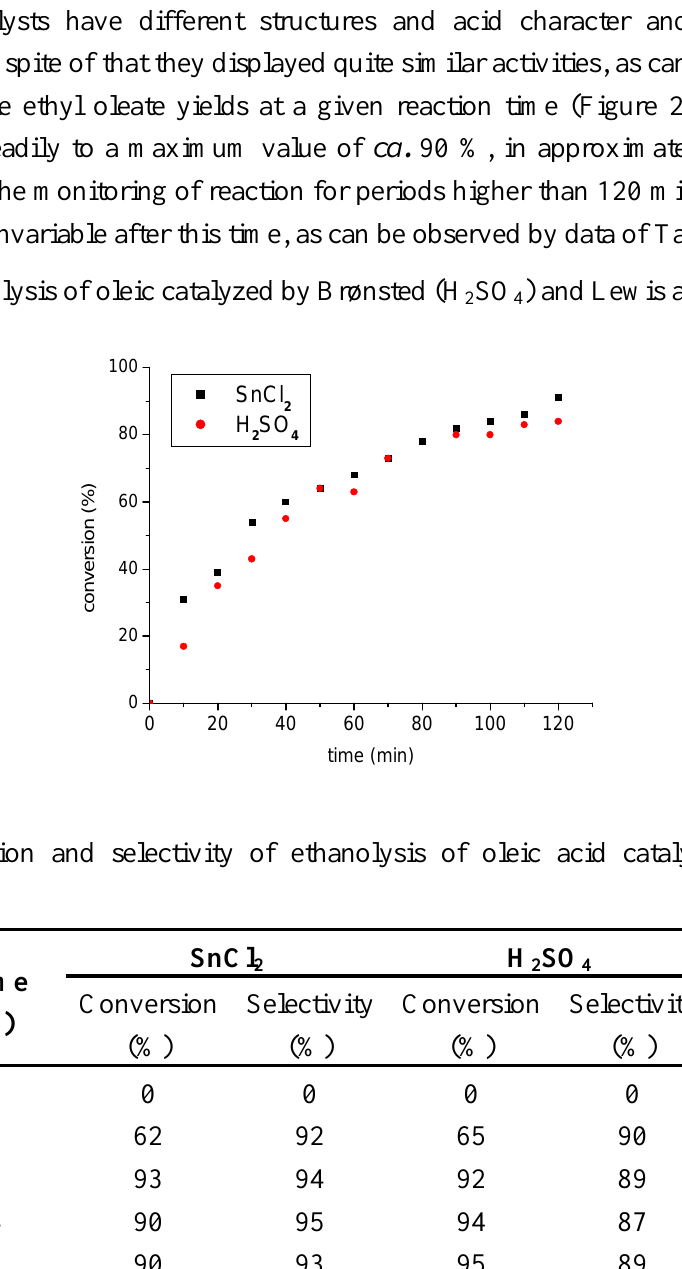
Figure 2 . Ethanolysis of oleic catalyzed by Brønsted (H